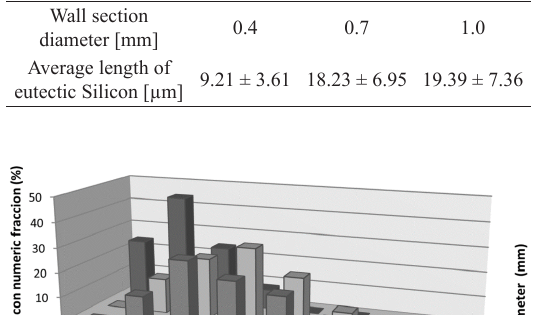
Table 8. Eutectic silicon average length of samples poured at 635 °C in a mold at 350 °C for different section diameters: 0.4 mm, 0.7 mm and 1.0 mm - [Zone 2].